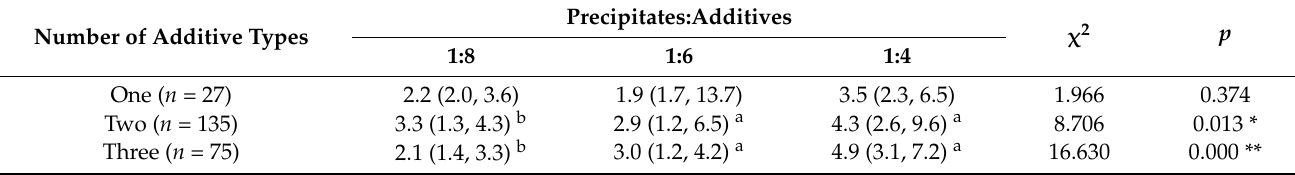
Table 2. Nonparametric analysis of viable bacteria counts at different proportions of precipitates and additives (CFU/g; Kruskal–Wallis).